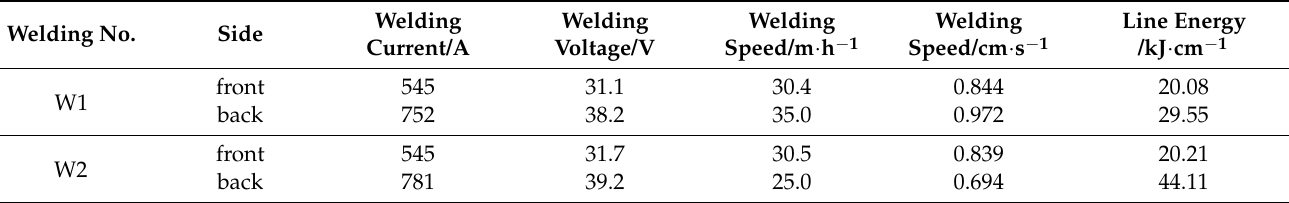
Table 5. Process parameter of submerged arc